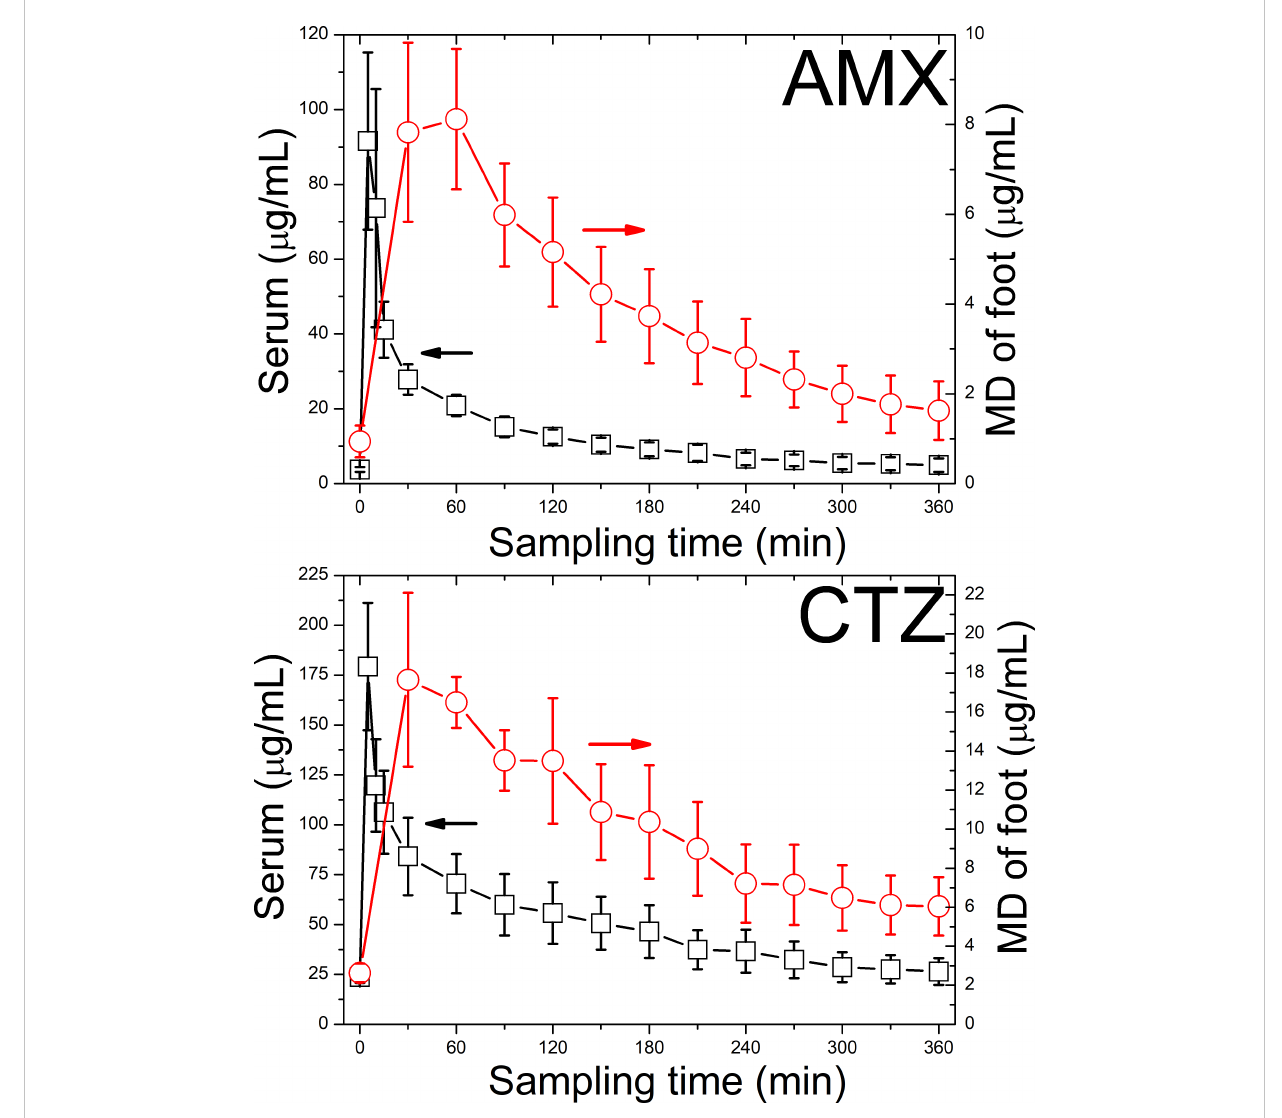
FIGURE 3 AMX and CTZ in the serum and MD of subcutaneous tissue in DF patients following i.v. bolus administration of AMOKSIKLAV (containing 1.2 g AMX) in 5 patients and FORTUM (containing 2.0 g CTZ) in 3 patients. The error bars indicate the standard error of mean (SEM). The determination was performed by the CE-C4D method with application of large volume sample stacking, which is described in the text and details in the original paper